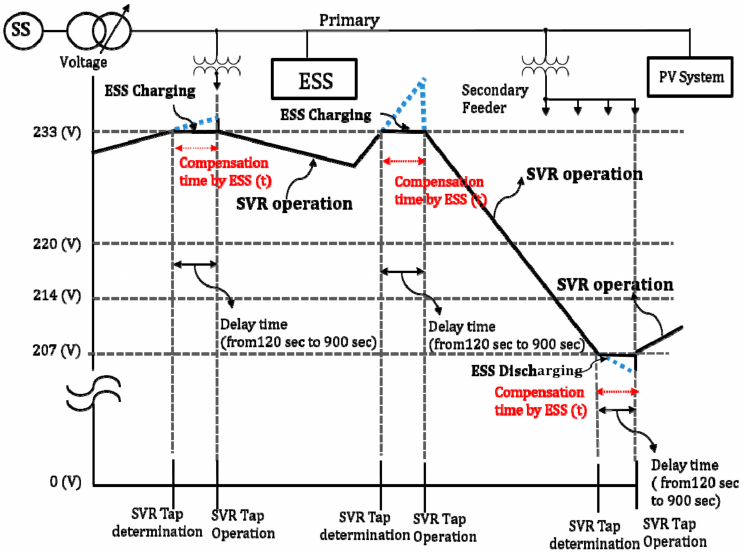
Figure 2. Voltage control of the SVR and energy storage system (ESS).